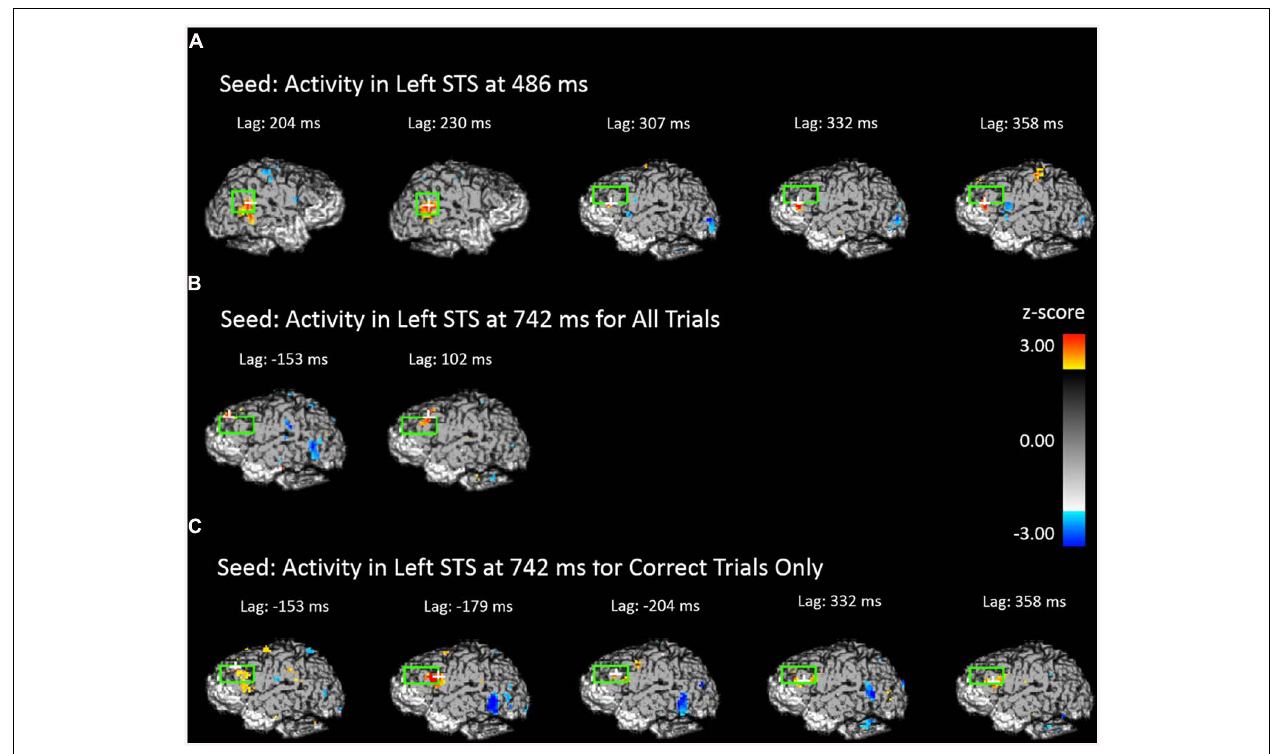
FIGURE 6 | Cross-correlational analyses using the peak activity during the scene preview for the contrast of old scenes > new scenes as the seed resel. The light green rectangle indicates the STS ROI for the first two images and the DLPFC ROI for all others. The white cross marks the peak resel within the ROI. (A) Areas of the brain and time shift that show above-threshold correlation in activity